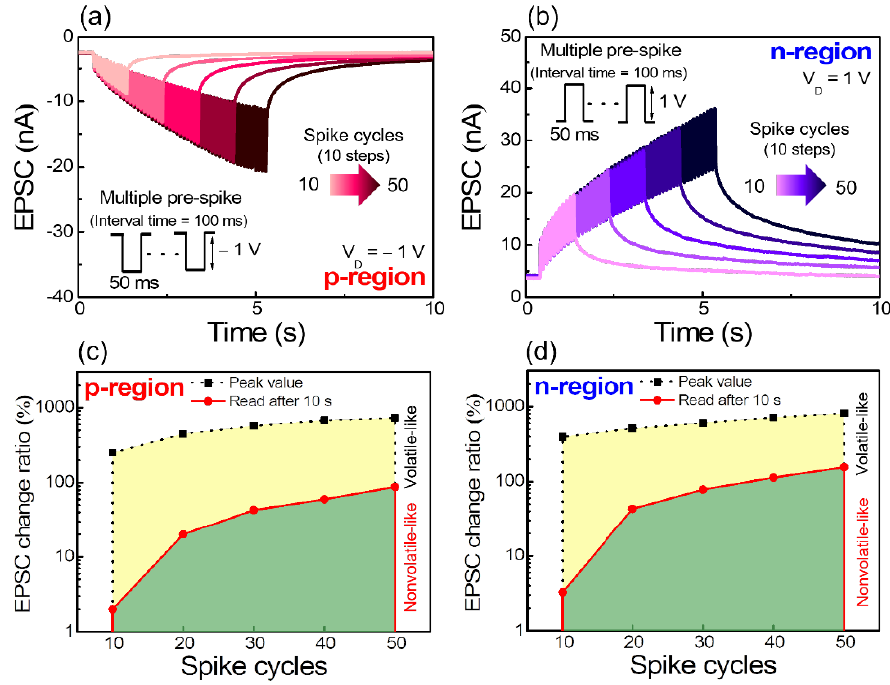
Figure 8. Dynamic EPSC retention characteristics in response to multiple pre-synapse spikes (10, 20, 30, 40, and 50 cycles) of the ( a ) p-region and ( b ) n-region. Spike cycle dependence of the EPSC change ratio at the ( c ) p-region and ( d ) n-region.